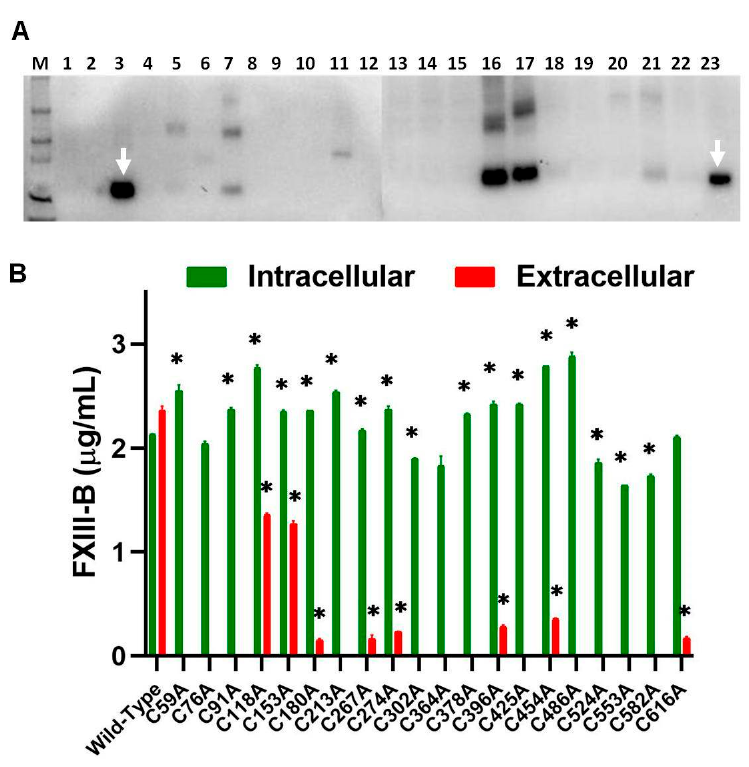
Figure 1. Transient expression of FXIII-B Cysteine mutants. Panel A. A conventional western blot of 10uL each of the wild type FXIII-B and 20 rFXIII-B cysteine mutants retained from the culture medium of transfected cells, probed against mouse to human FXIII-B antibody. Lanes: 1: Un-transfected control; 2: C76A; 3: Wild-Type; 4: C364A; 5: C396A; 6: C425A; 7: C454A; 8: C524A; 9: C553A; 10: C582A; 11: C616A; 12: C486A; 13: C378A; 14: C59A; 15: C91A; 16: C118A; 17: C153A; 18: C180A; 19: C213A; 20:C267A; 21:C274A; 22: C302A; and 23: rFXIII-B (Zedira, 75ng, positive control) White arrows represent the wild-type FXIII-B. Panel B. A comparative bar-plot representation of the antigenic levels of FXIII-B cysteine mutants versus the FXIII-B wild type evaluated on a quantitative sandwich ELISA based platform, detecting FXIII-B in 100µL of sample retained from transiently transfected cells. Green and red bars represent the intracellular and the extracellular fractions, respectively. A “*” symbol represents significance ( p -value < 0.05).